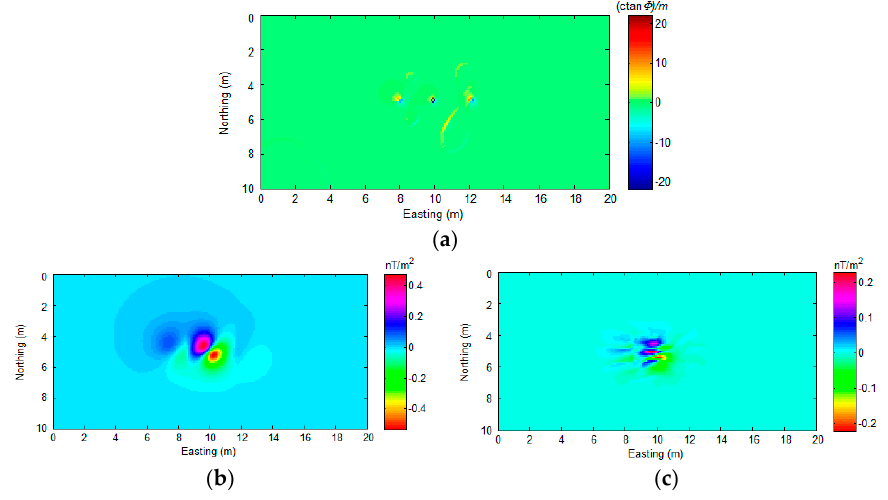
Figure 11. The gradient of the detection results for ( a ) Figure 9, ( b ) Figure 10a, and ( c ) Figure 10b.